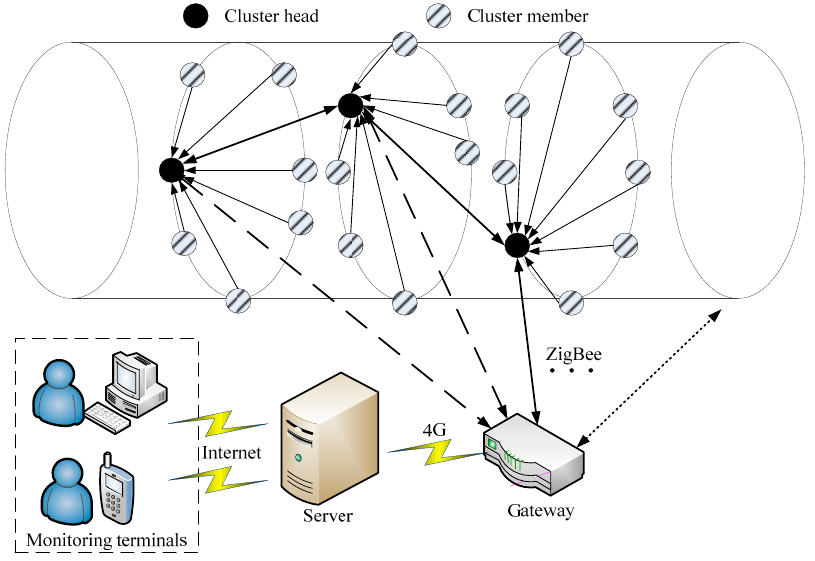
Figure 3. The tunnel monitoring system based on the long and linear cluster structure.